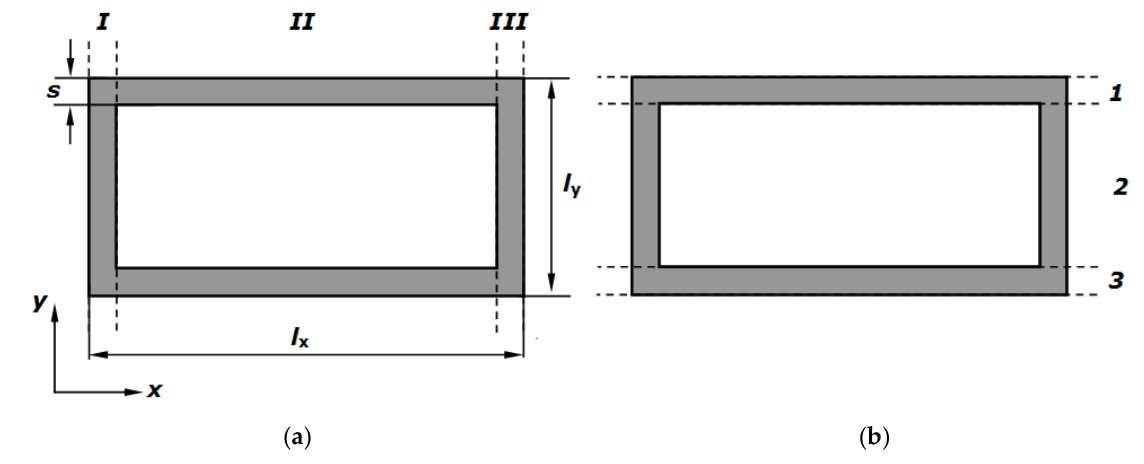
Figure 25. Division of a section into: ( a ) vertical zones I-III ; ( b ) horizontal layers